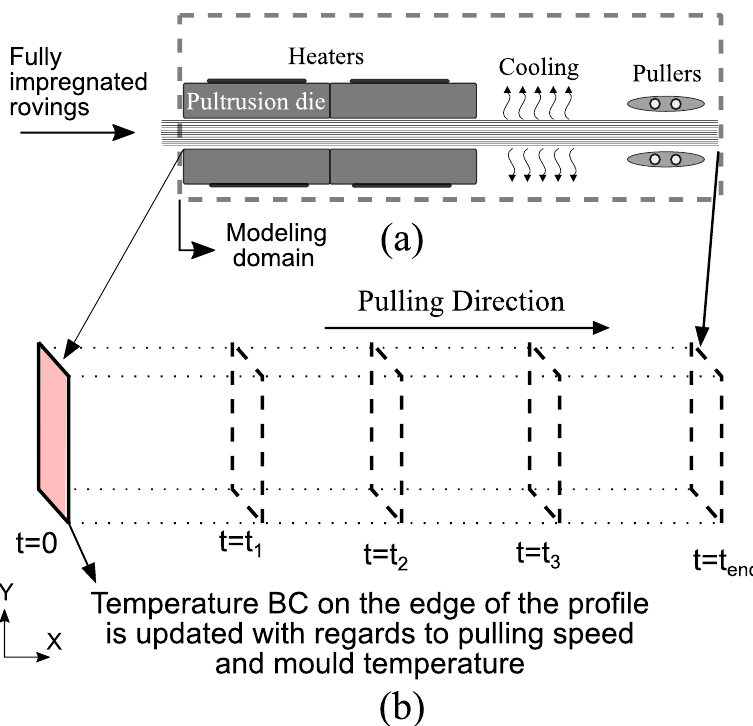
Figure 3. ( a ) Schematic representation of a pultrusion line and the modeling domain. ( b ) Schematic representation of the modeling